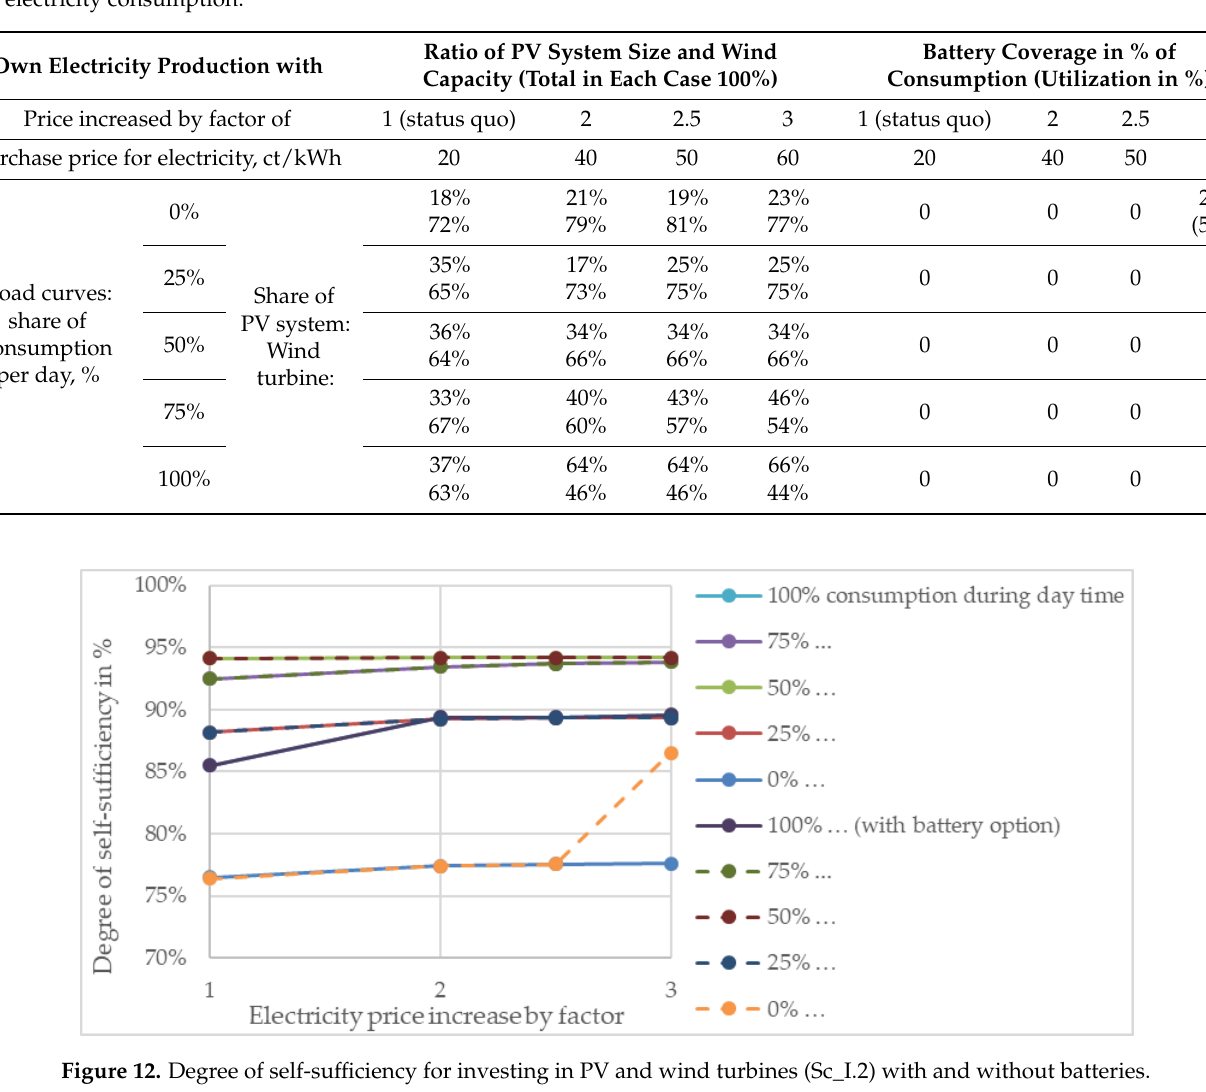
Table 8. Technology of electricity production with renewable energy from wind and PV with battery: size of shares in wind turbine, PV system and battery, and battery utilization in % when limited to a maximum of 200% of farm’s electricity consumption.